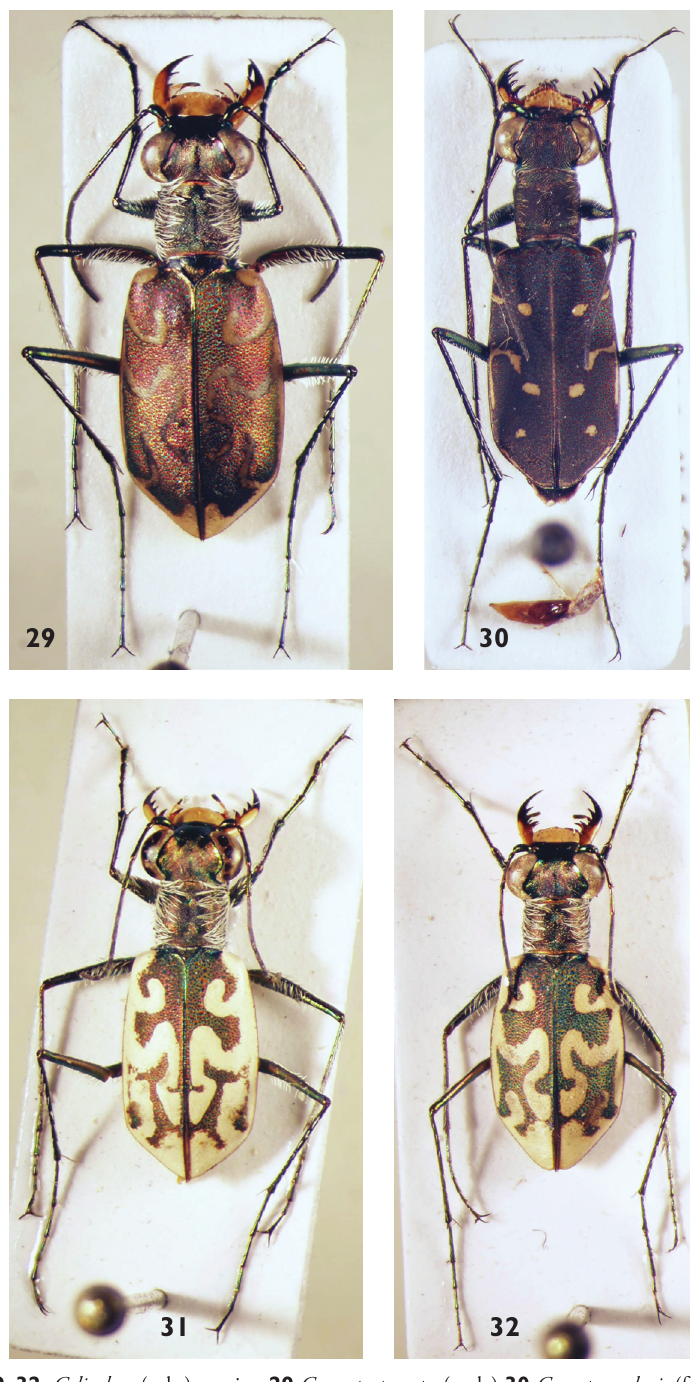
Figures 29–32. Cylindera (sub-) species: 29 C. contorta s.str. (male) 30 C. rectangularis (female) 31 C. contorta valdenbergi (male) 32 C. contorta valdenbergi